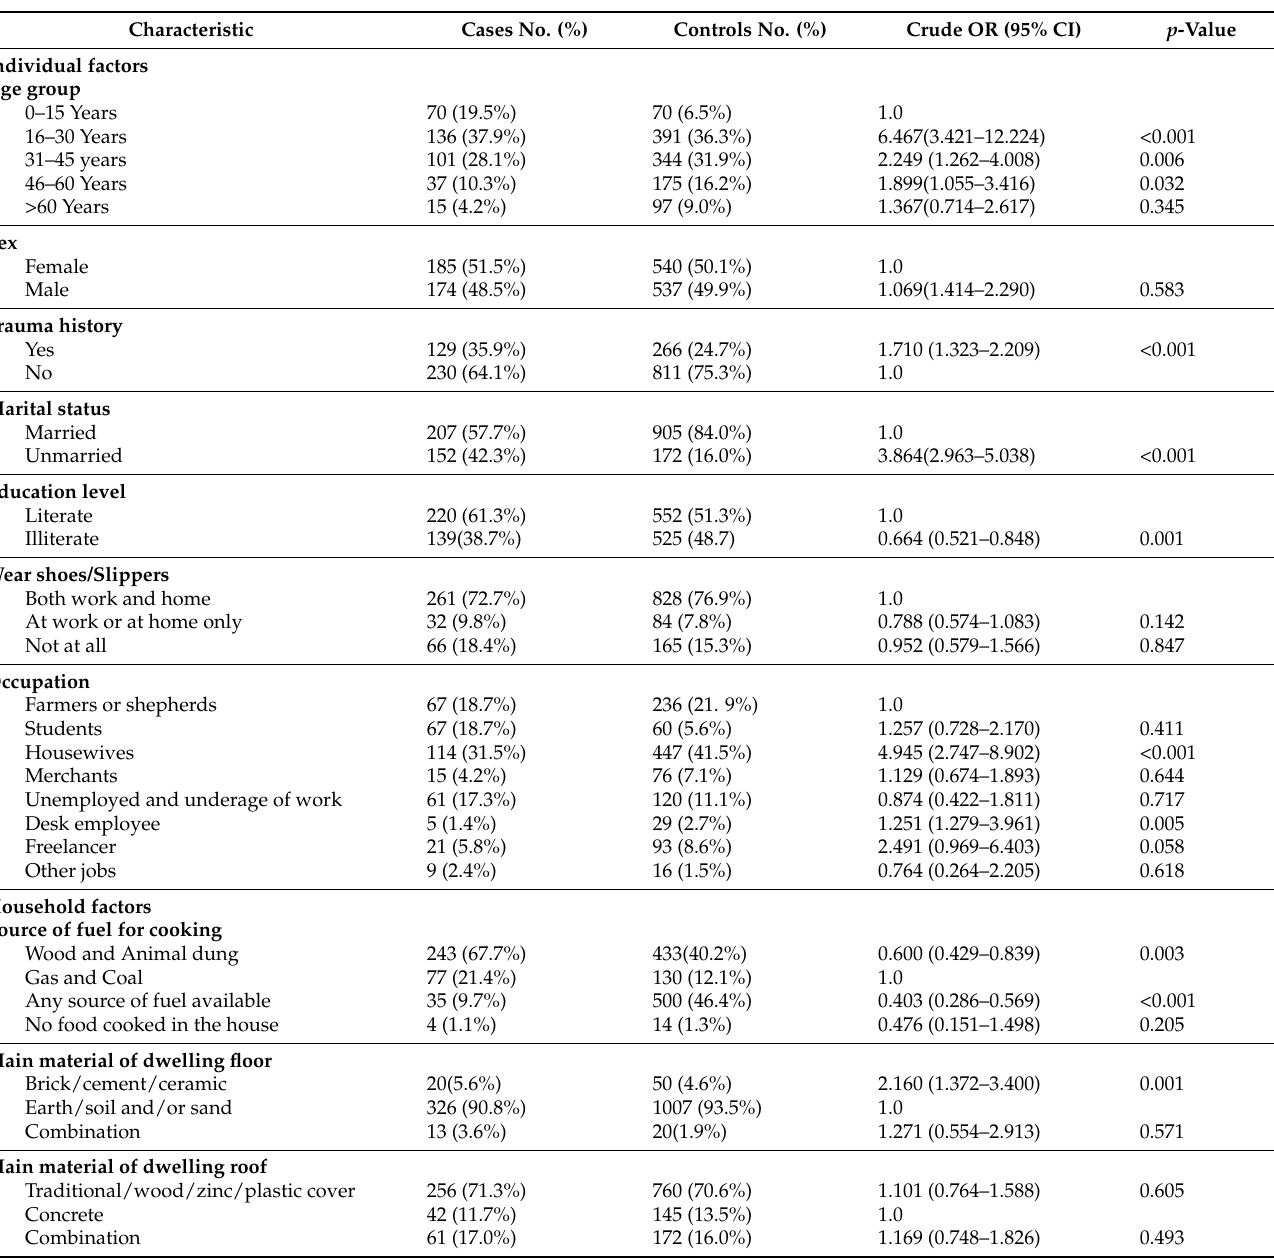
Table 1. Demographic characteristics of confirmed cases and controls, showing unadjusted odds ratios (OR) for mycetoma risk factors (n =